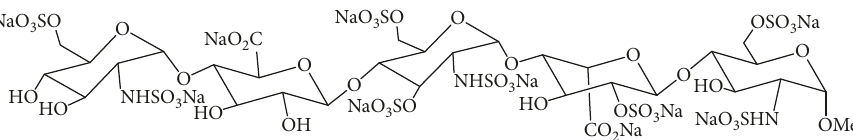
Figure 1: Structure of